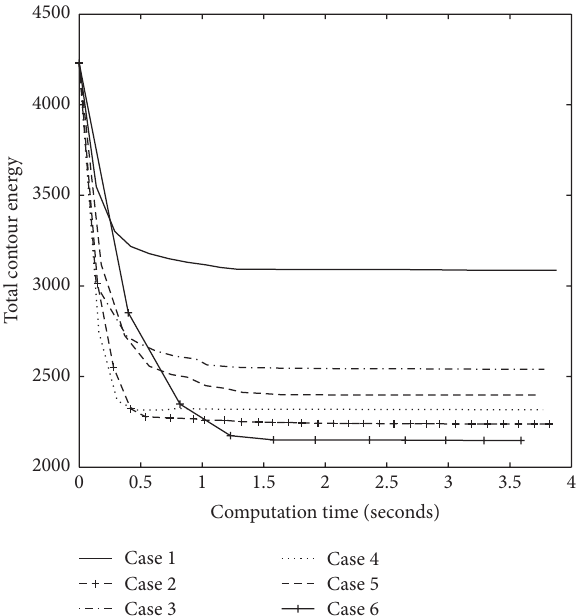
Figure 9: Contour energy versus computation time plot for “pro- posed multiswarm PSO” method with six different cases of inertia in case of “Vase”